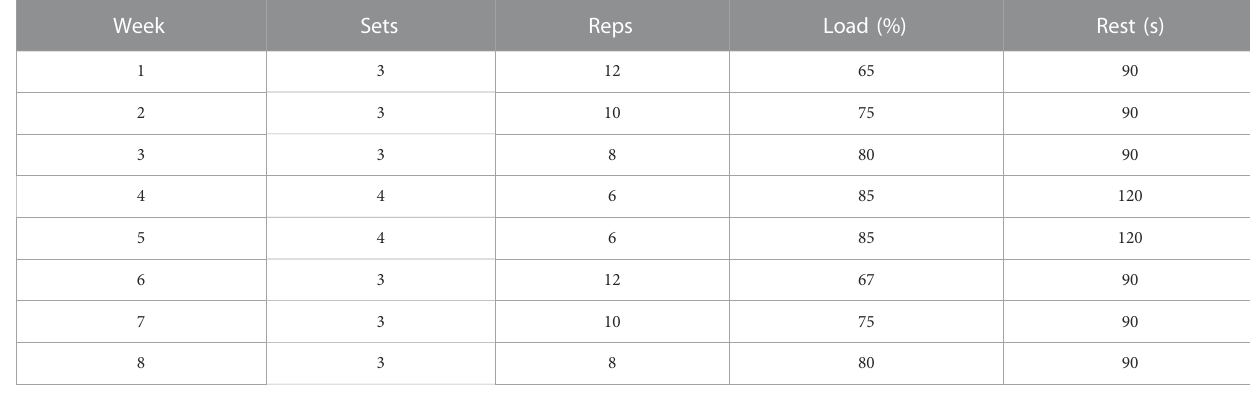
TABLE 1 Resistance training program details. Week